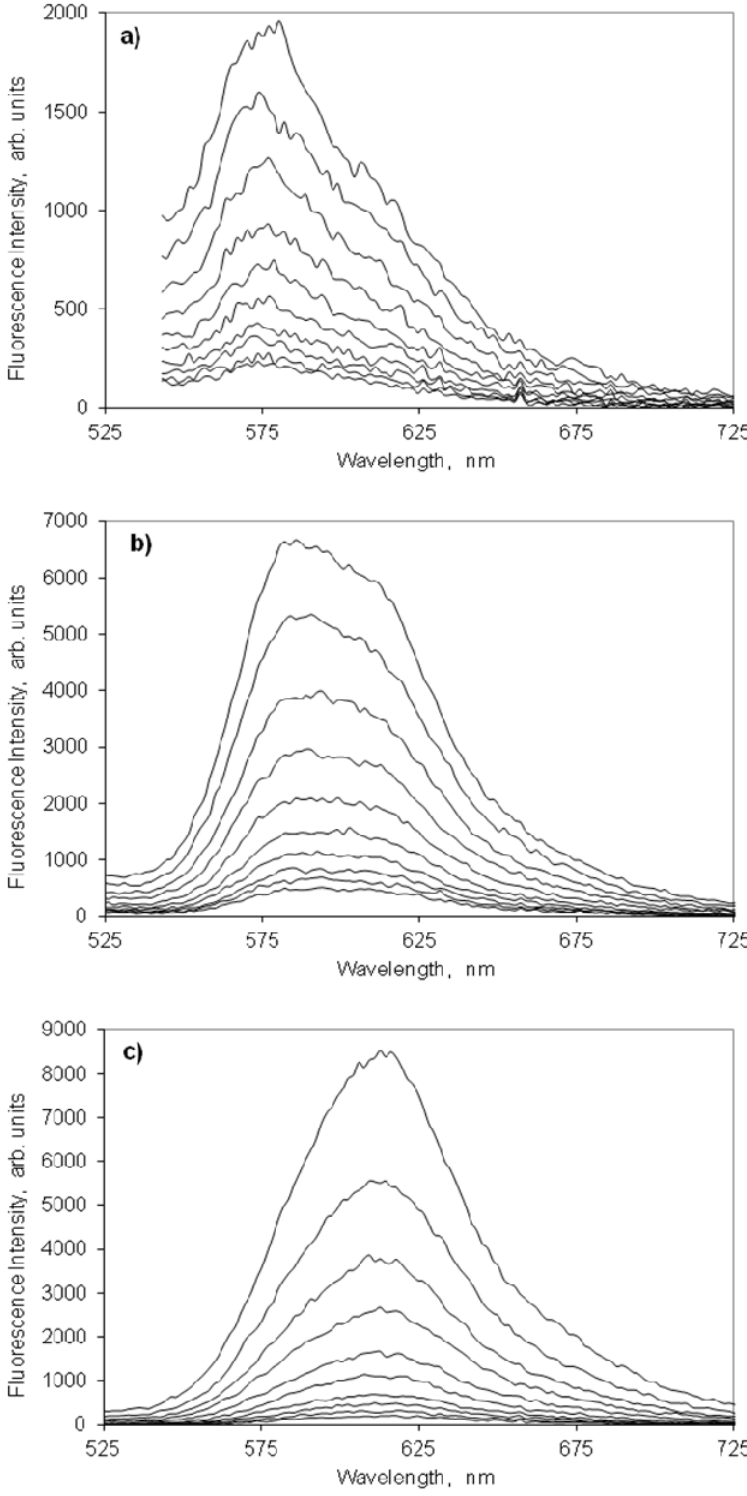
Figure 6. Laser induced time resolved spectra of the 3,3'-di(2-sulfoethyl)-indocarbocyanine dye on microcrystalline cellulose. Curve 1 = 0 ns; Step = 1 ns. Concentrations are ( a ) 0.05, ( b ) 0.5 and ( c ) 10 μ moles of the cyanine dye per gram of microcrystalline cellulose. The excitation wavelength was 337